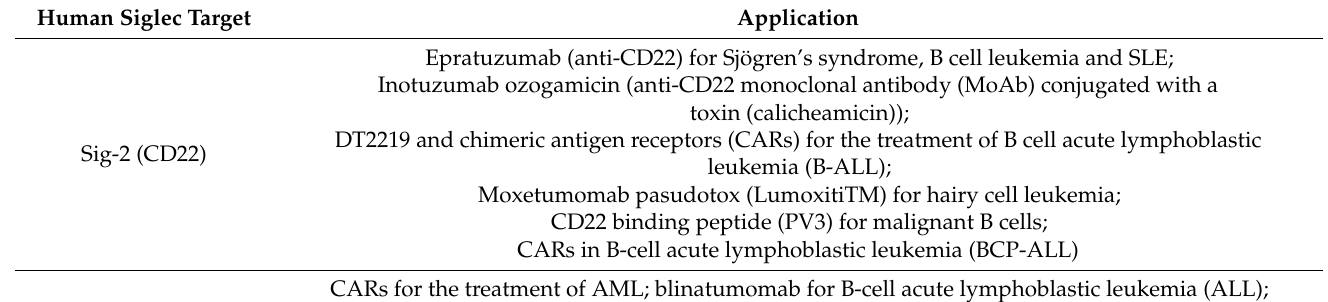
Table 2. Therapeutic approaches based on